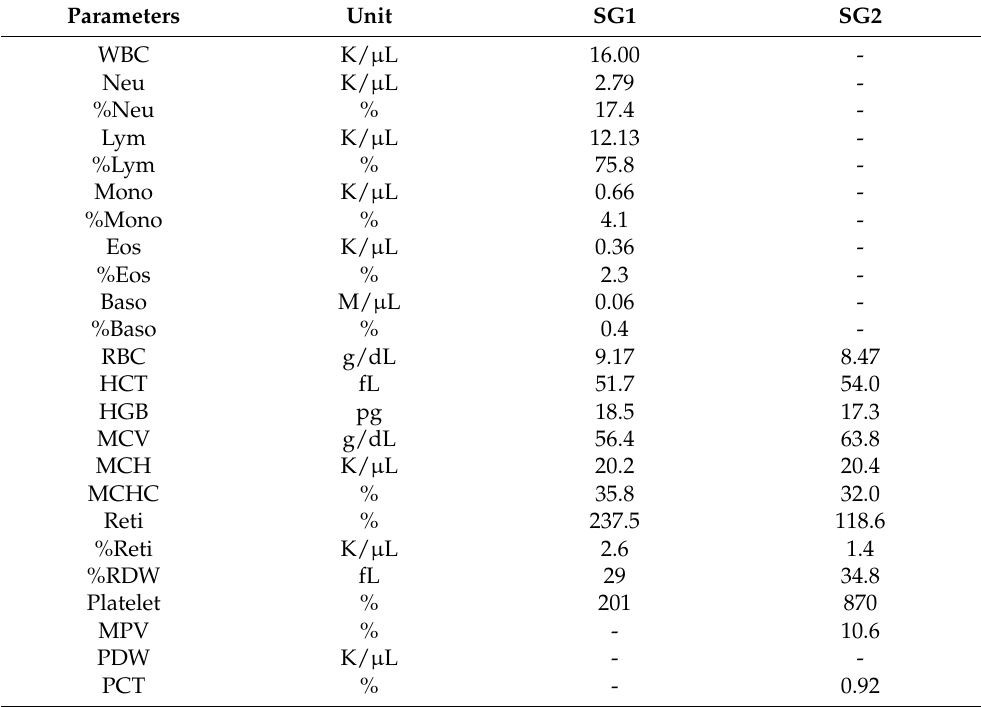
Table A1. Hematology data of two sugar gliders under one year old. Missing data was caused by errors in the analyzing process, possibly due to insufficient sample volume.